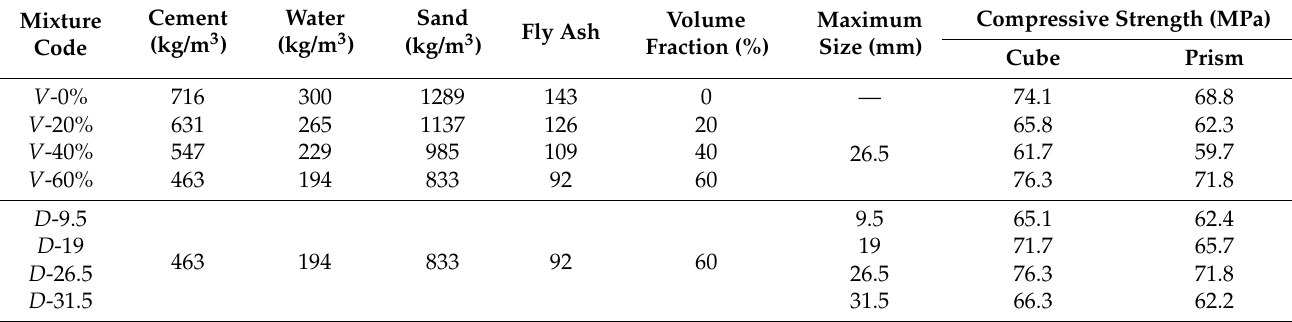
Table 1. The mix proportions of concrete.